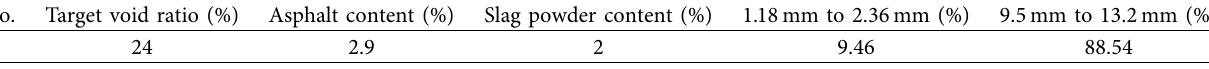
Table 15: Matrix asphalt crushed Marshall test.